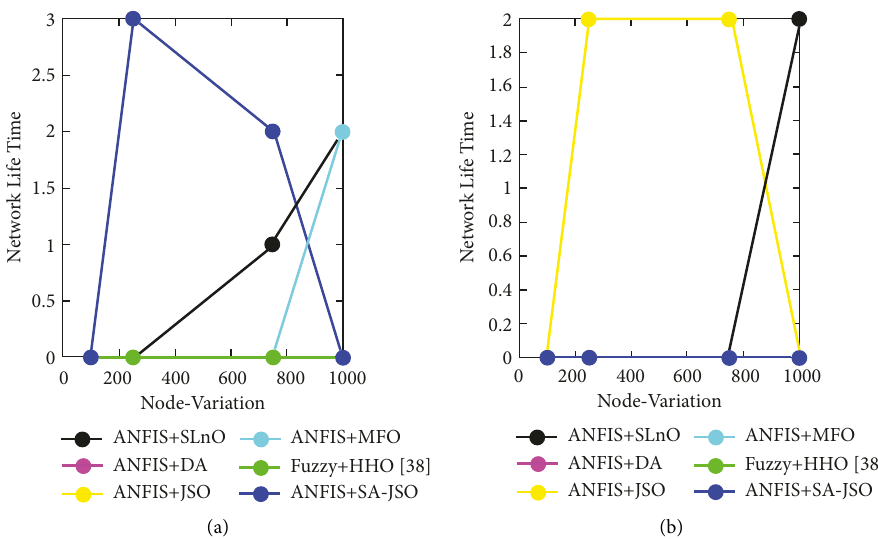
Figure 7: Analysis of the life span of developed approach over compared approaches regarding (a) group 1 and (b) group